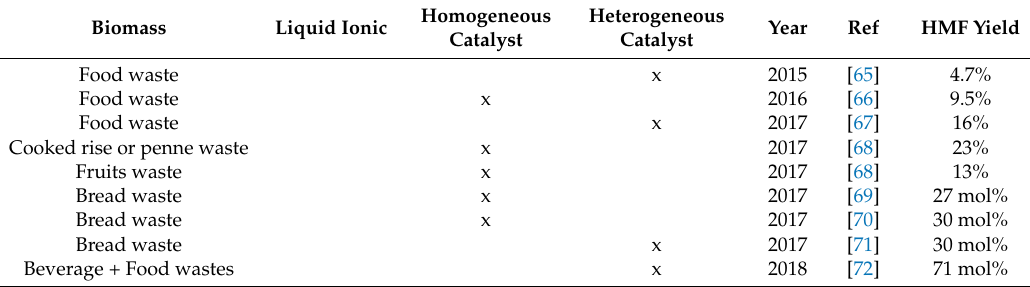
Table 3. HMF production from food